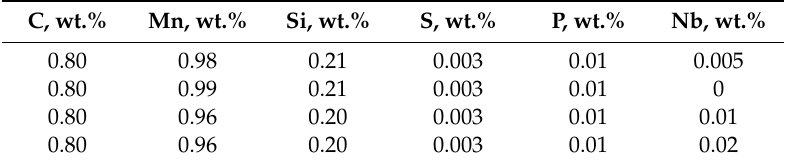
Table 3. Chemical composition of 0.8 wt.% carbon steel specimens (Weight